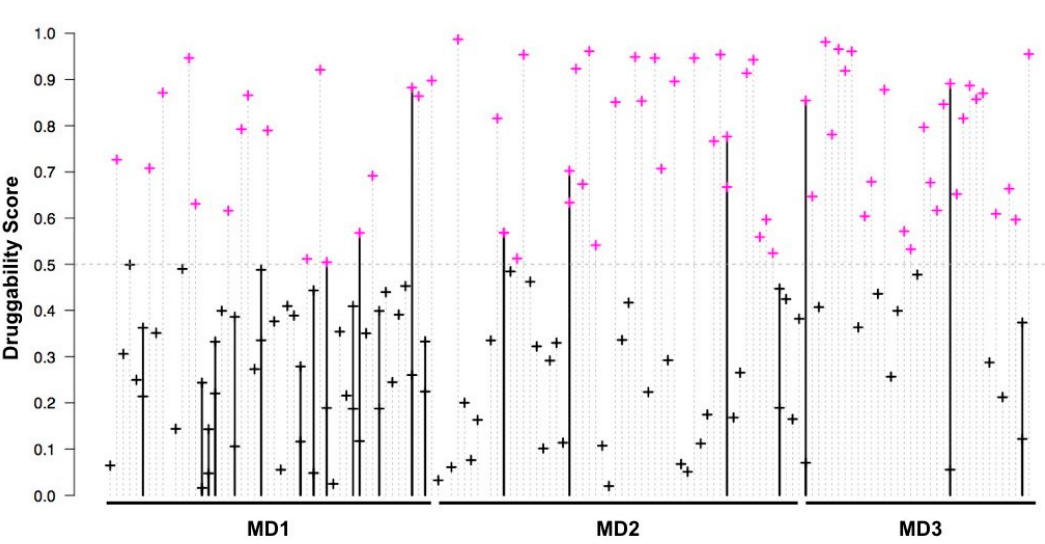
Figure 3. Druggability of the 159 pockets identified in the groove region for the 140 sampled FL conformations, obtained on three independent dynamics. Vertical lines stand for the consecutive conformations that were sampled (at 1 ns intervals) along each of the three Molecular Dynamics (MD) trajectories, with the terminating cross representing the druggability score of its groove pocket(s). Druggable pockets (druggability score ≥ 0.5) are in violet, the others are in black. Bold lines (with two dots) represent the 21 conformations that contained two groove pockets.